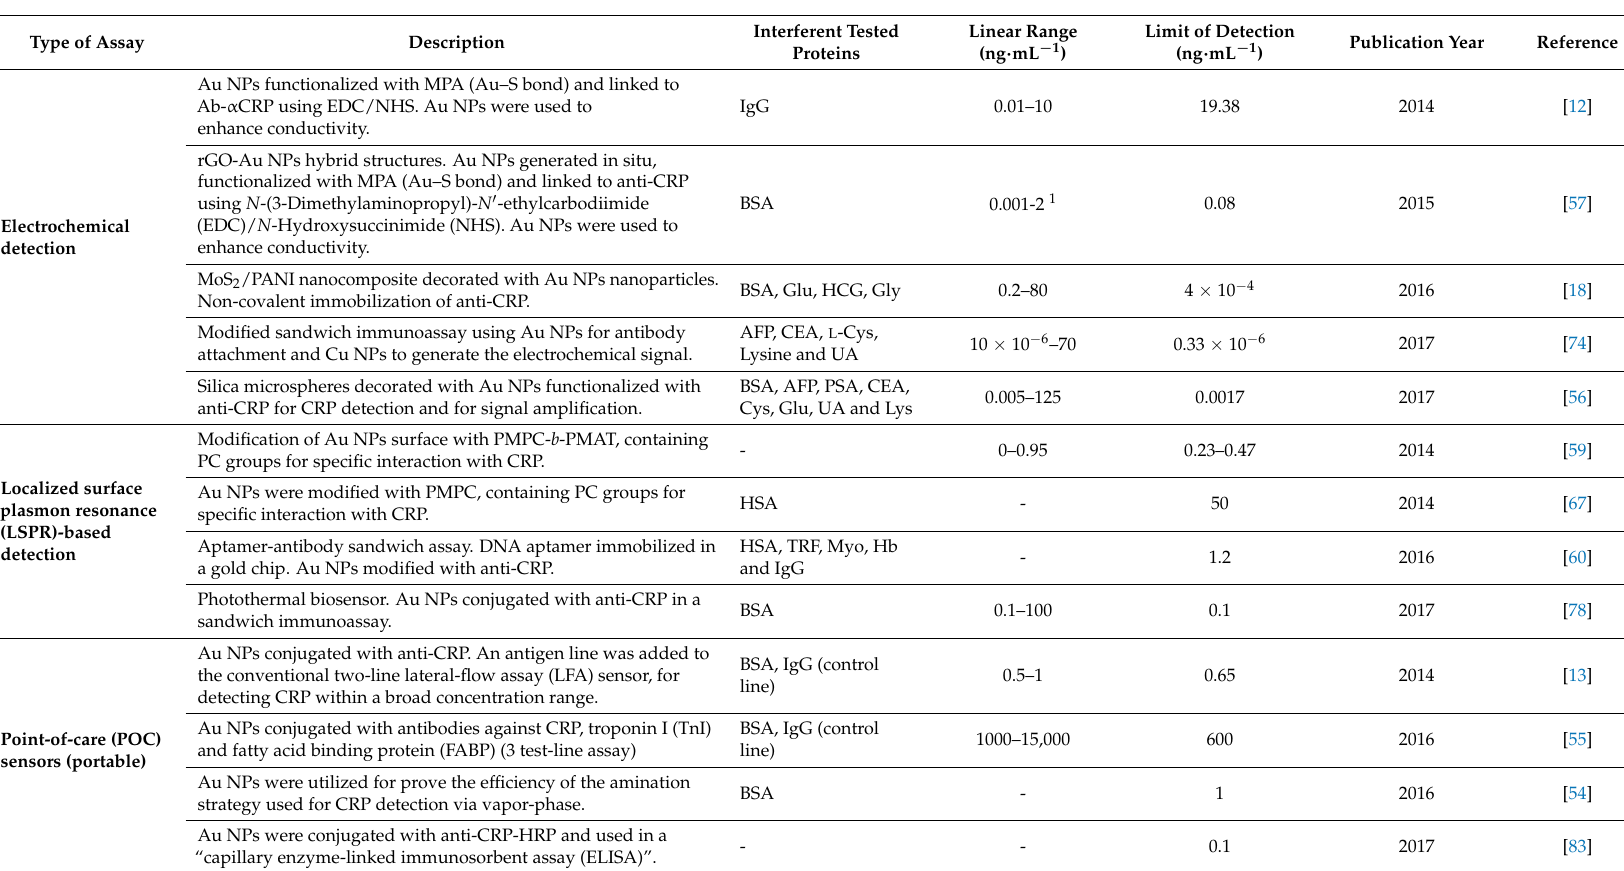
Table 2. Summary of most representative assays for CRP detection based on Au NPs. Information is provided regarding the linear range of CRP detection (ng · mL − 1 ), the interfering protein tested and the limit of detection (ng · mL − 1